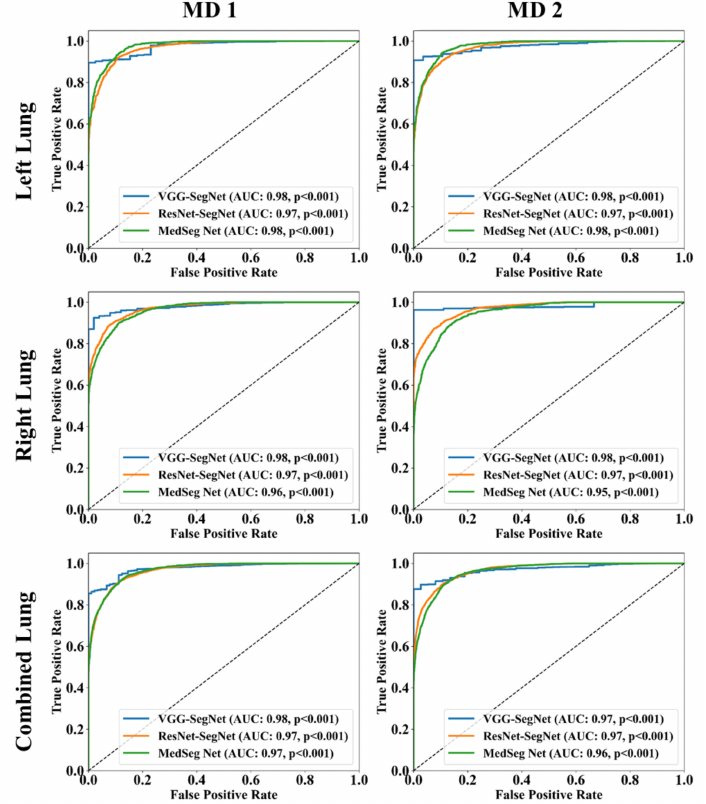
Figure 15. ROC plot: COVLIAS vs. MedSeg. Row 1: left lung, row 2: right lung, row 3: combined lung. Left: using MD 1, Right: using MD